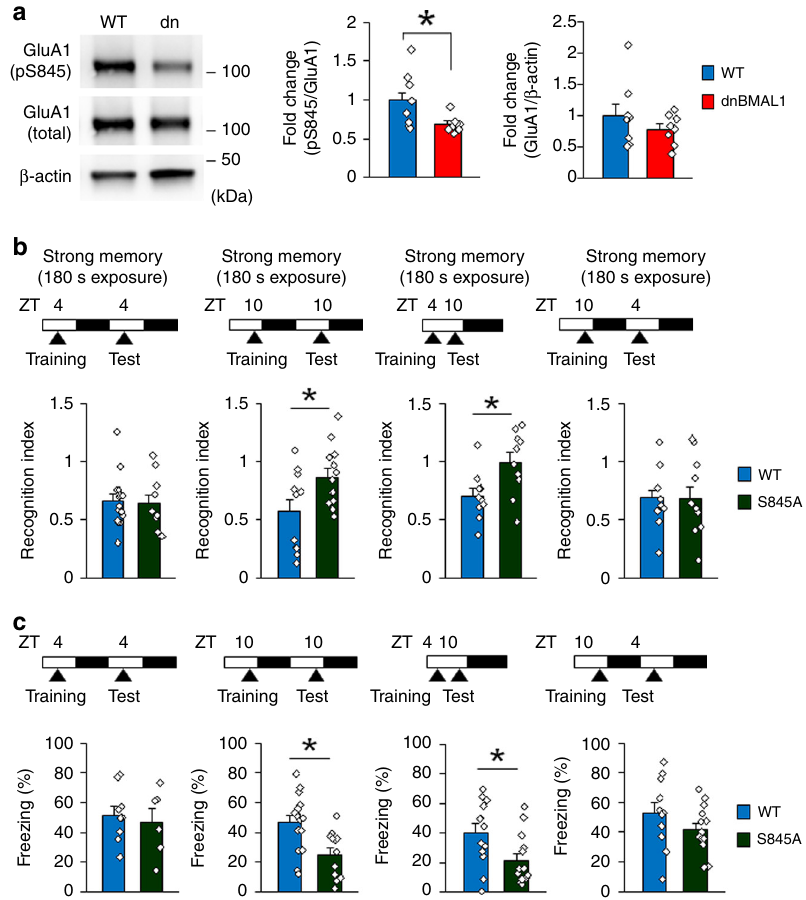
Fig. 6 Phosphorylation of GluA1 S845 is required for memory retrieval. a Western blotting of the synaptosomal fraction from dorsal hippocampus of dnBMAL1 mice show signi fi cant reduction of phosphorylation level of GluA1 S845 (pS845). The graph represents fold changes compared to pS845 levels in WT. b , c Experimental designs are illustrated at the top of each panel. Memory retrieval is impaired at ZT10 in GluA1 S845A knockin (S845A) mice in b social recognition task (recognition index) and c contextual fear memory. dn dnBMAL1. All values are mean ± SEM. Individual data points are displayed as dots. * p < 0.05 as determined by one-way ANOVA with post hoc test. The results of the statistical analyses are presented in Supplementary Table 2. Source data are provided as a source data fi